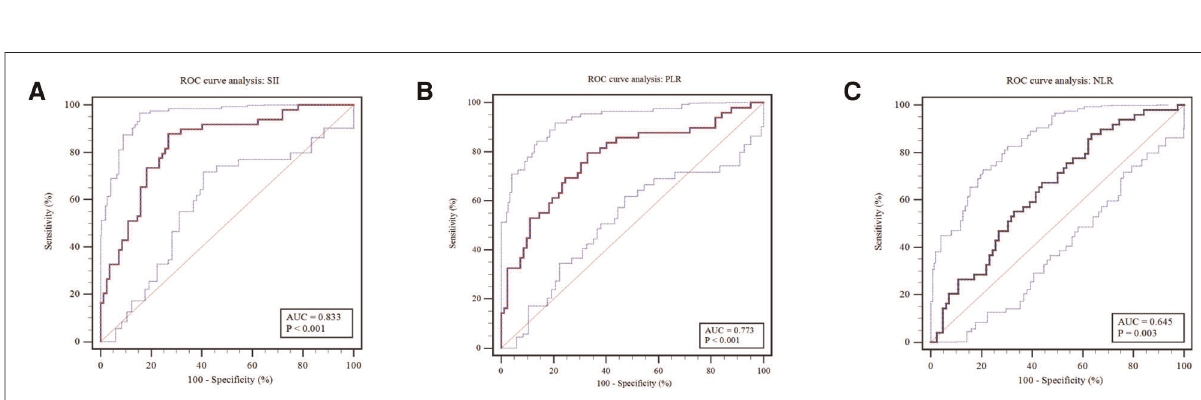
FIGURE 3 Receiver operating characteristic curves were plotted to determine the optimal cut-off value for ( A ) SII, ( B ) PLR and ( C ) NLR. SII, systemic, immune- in fl ammation index; PLR, platelet-to-lymphocyte ratio; NLR, neutrophil-to-lymphocyte